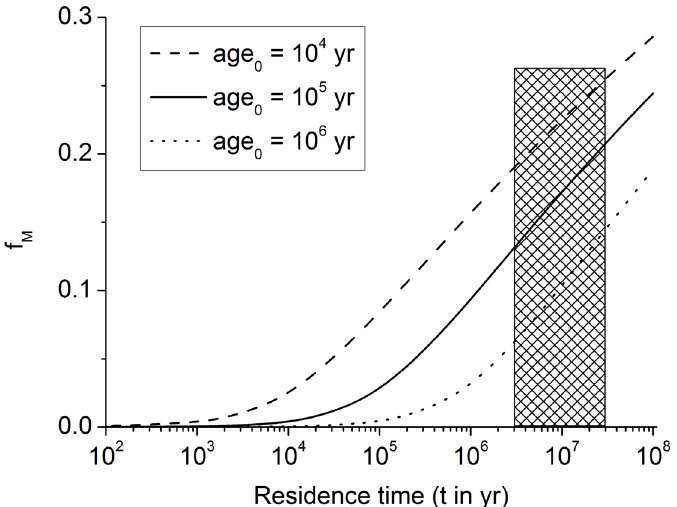
Figure 6. Fraction of POC converted into methane carbon within the methanogenic zone of ). The marked area indicates the range of POC residence continental margin sediments ( f M times ( t = 3–30 Myr) within the methanogenic zone at continental